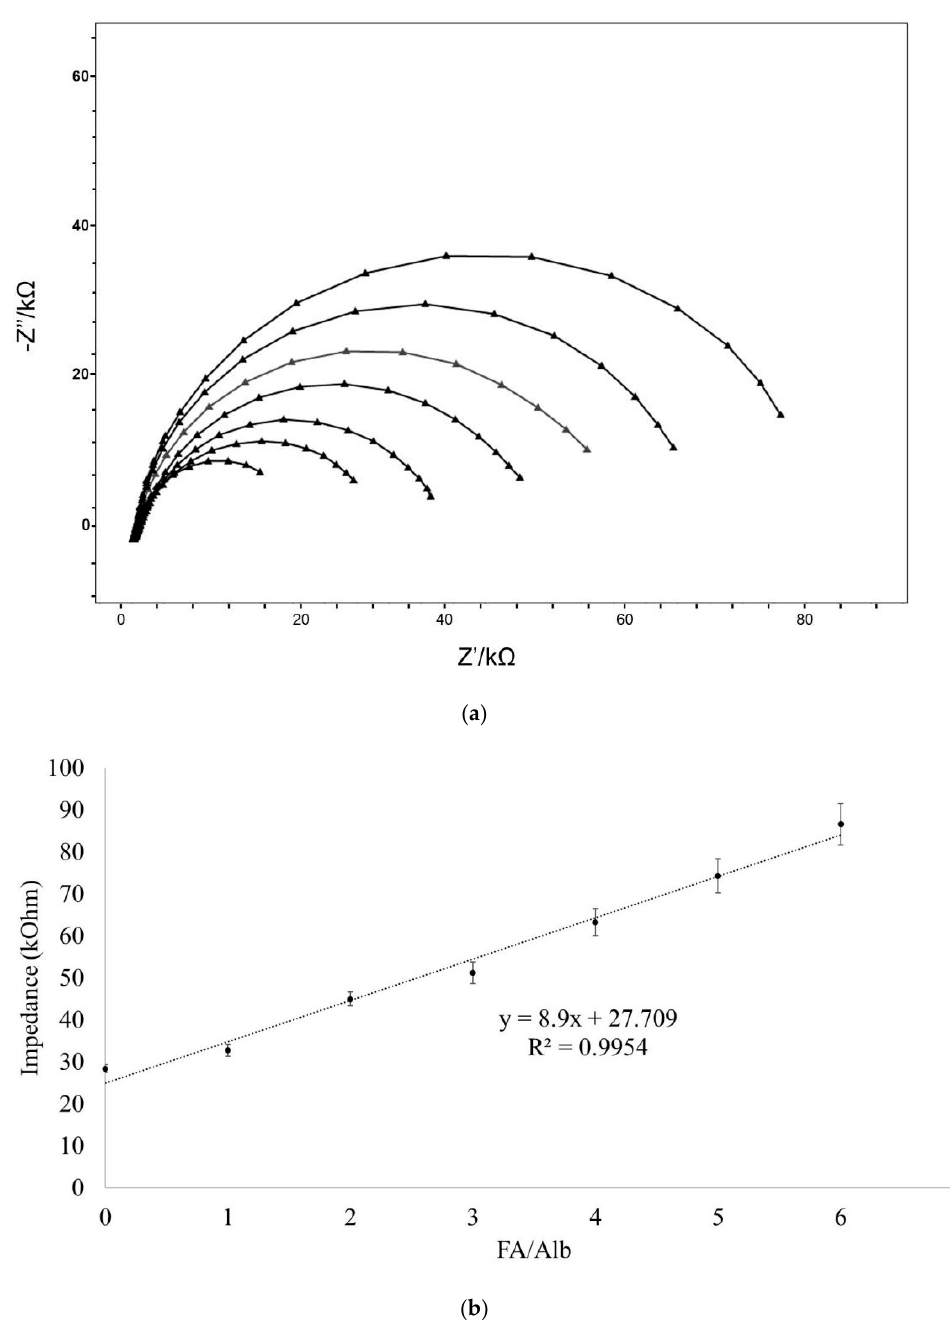
Figure 4. ( a ) Frequency-ranged Faradaic EIS for each FA/Alb ratio from 0 (i.e., blank/no FAs) to 6, immediately following 80 s incubation period; ( b ) calibration graph with good linearity. The term “impedance” in the graph denotes the charge transfer resistance.